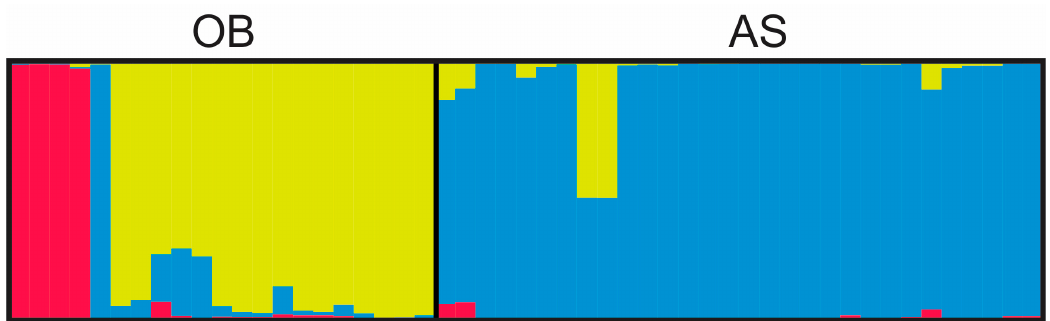
Figure 5. Bayesian barplot showing genotyping structure of P. falciparum. OB, Obom and AS, Asutsuare. Three genetic clusters were detected (color in pink, yellow and blue). Samples of OB had predominantly the yellow cluster followed by the pink and blue clusters; samples from AS had mostly the blue cluster. Only monoclonal and biclonal samples, of which multilocus genotypes were identified, were included in this analysis.